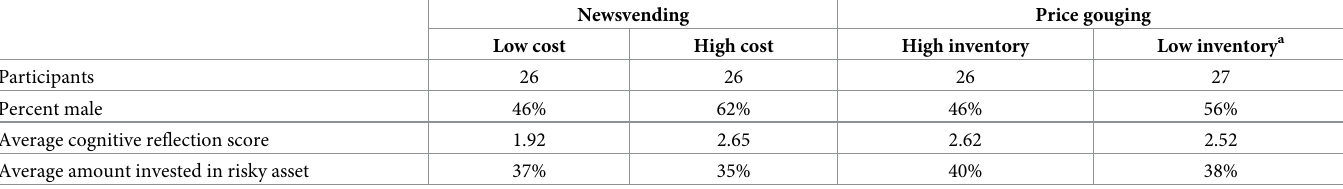
Table 1. Participant characteristics by